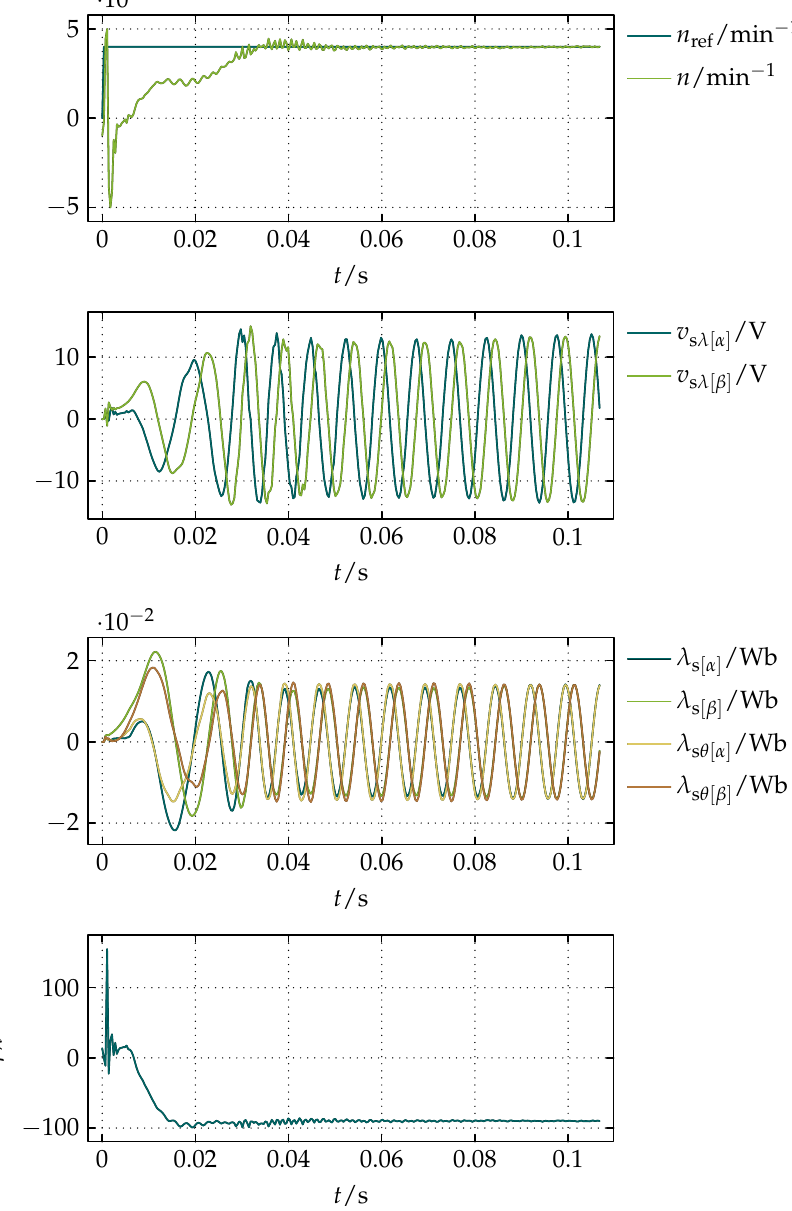
Figure 15. Results of an experiment of a step in n from 0 to 4000 min − 1 for k = 0.5 and ω c = ω n